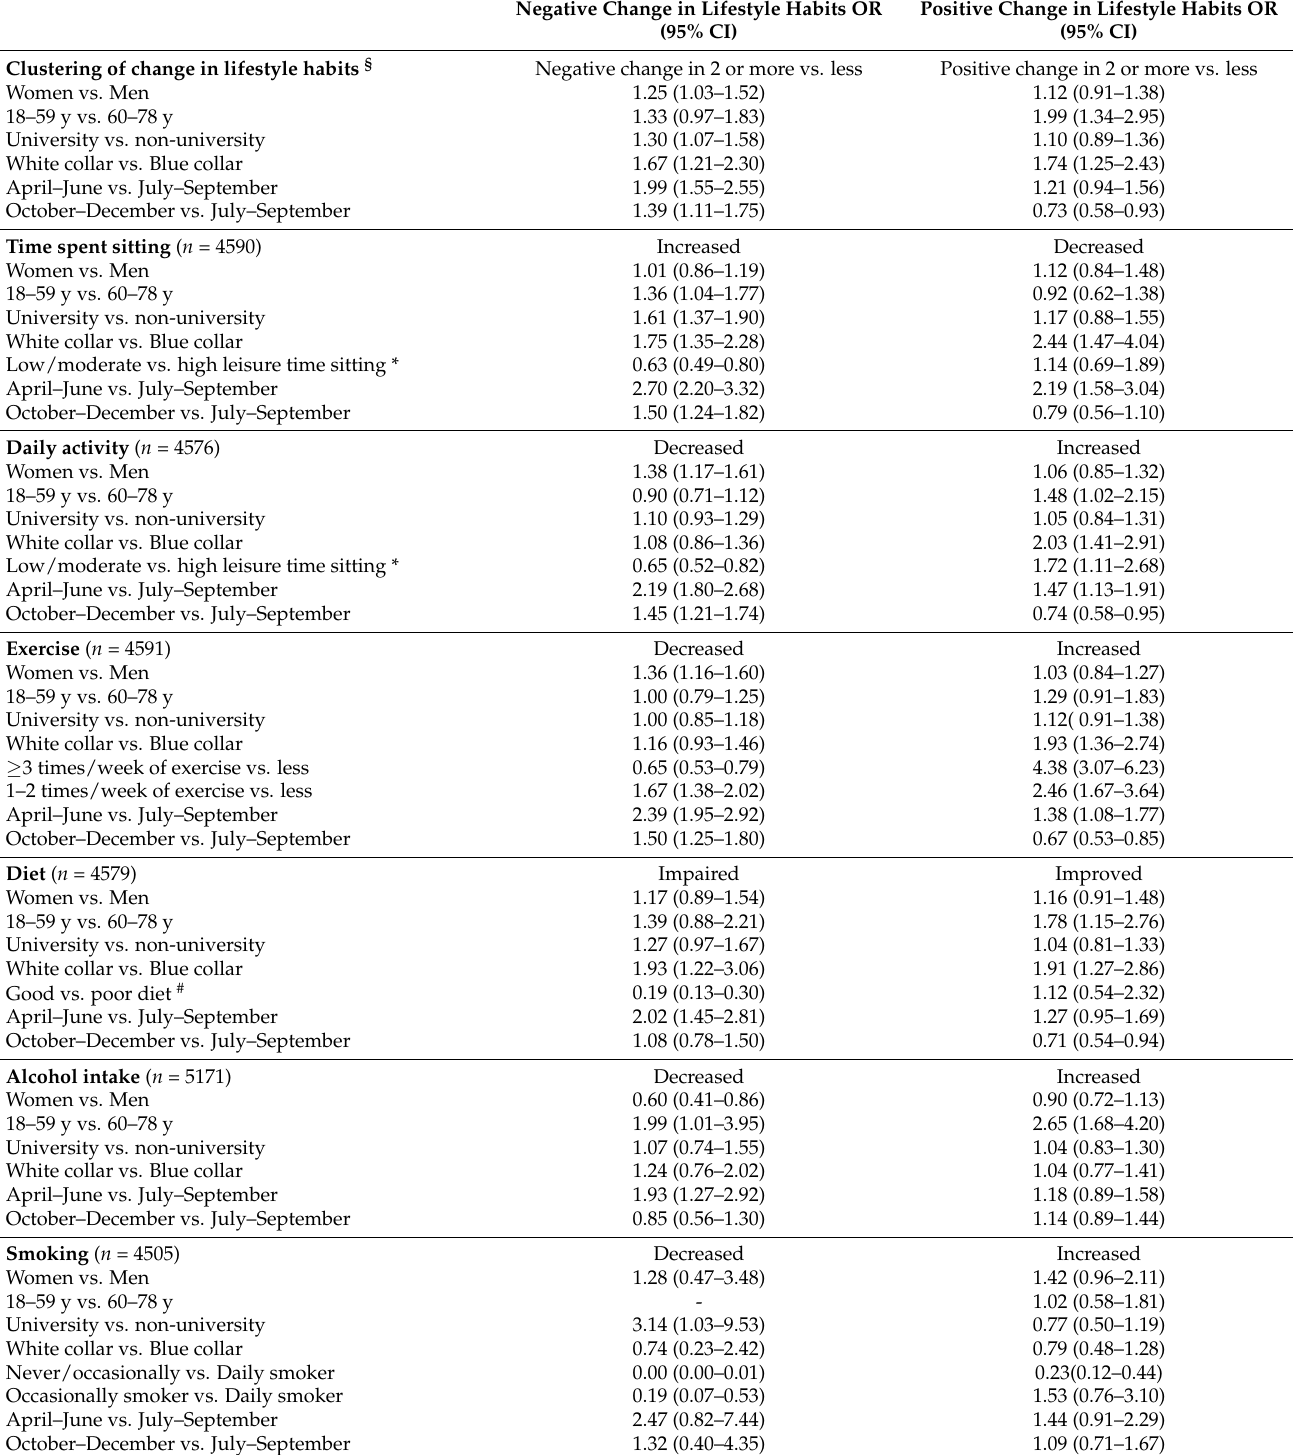
Note: All analyses mutually adjusted for sex, age group, educational level, occupational group, wave of COVID-19, and baseline values for each lifestyle habit (except for alcohol, see text and Appendix B Table A2). * HPA question regarding sitting in leisure, coded as Low/moderate = “Almost no time”, “25% of time”, “50% of time” and High = “75% of time”, “All the time”. # HPA question regarding diet, coded as Good = “Very good” or “Good” and Poor = “Neither good or bad”, “Poor”, “Very poor”. § Including change in time spent sitting, exercise, diet, alcohol, and